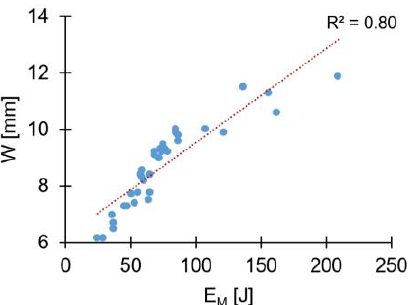
Figure 16. Correlation between maximum width of the deformed rivet tip (W), and the total mechanical energy input (E M ).